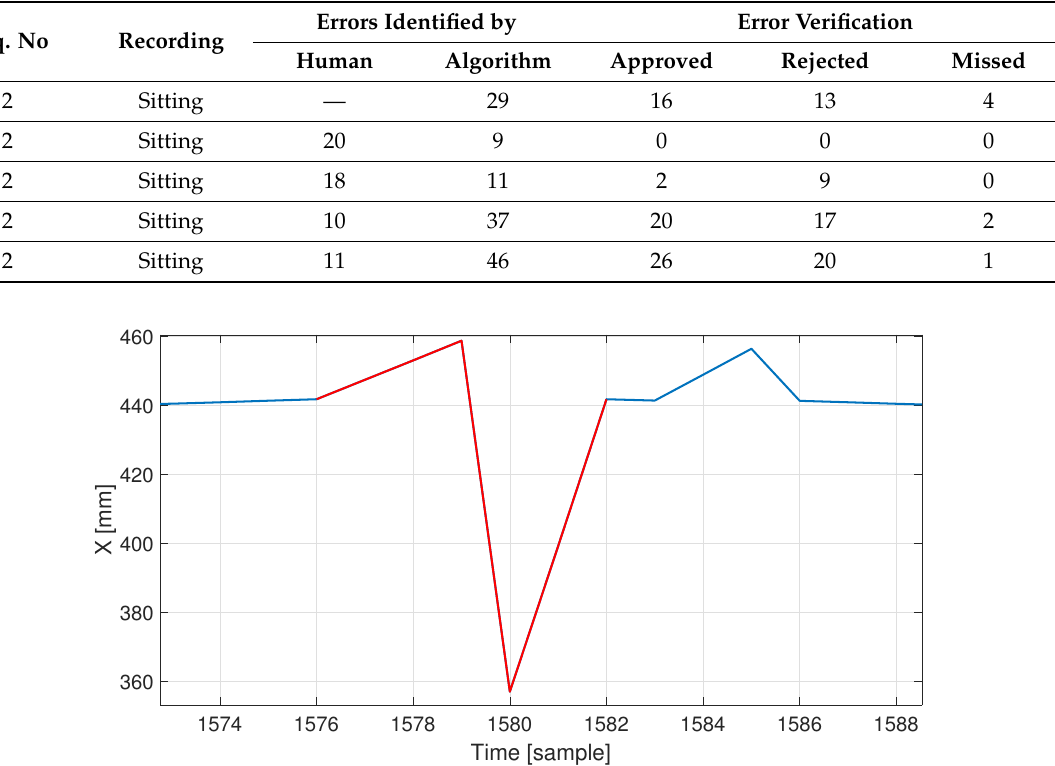
Table 2. Comparing the number of distortions located by the proposed method to the human operator (E2).